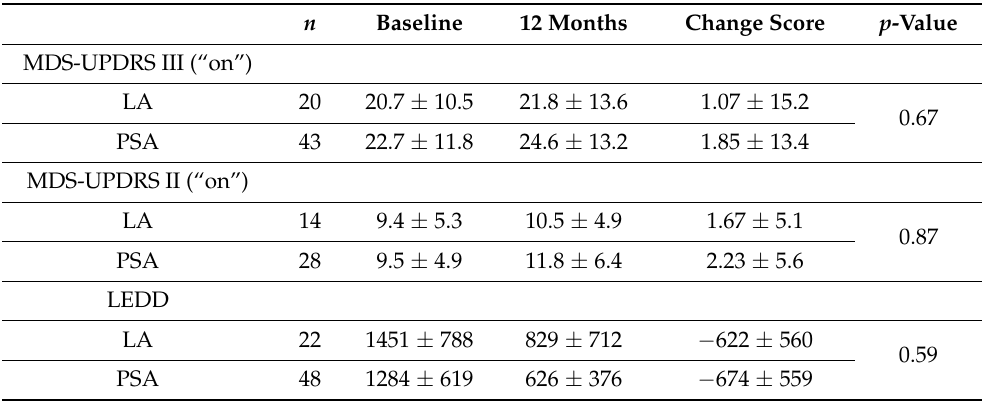
Table 2. Motor outcome change scores at 12